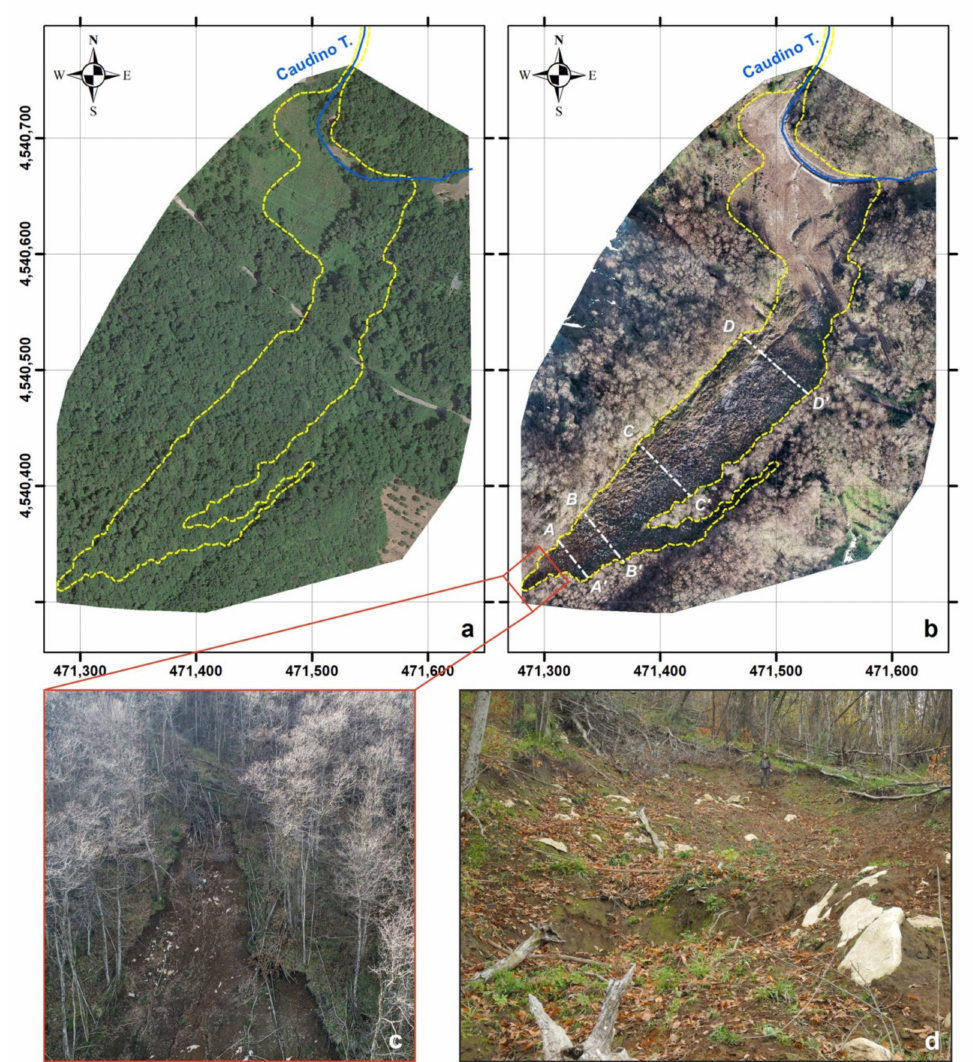
Figure 9. Landslide area of December 2019: ( a ) June 2019 Google Earth view; ( b ) January 2021 UAV view, with traces of the topographic profiles (AA’, BB’, CC’, DD’) shown in Figure 11; ( c , d ) details of the upper landslide area bounded by the red rectangle in Figure 9b. The images were acquired from two different points of view, looking from